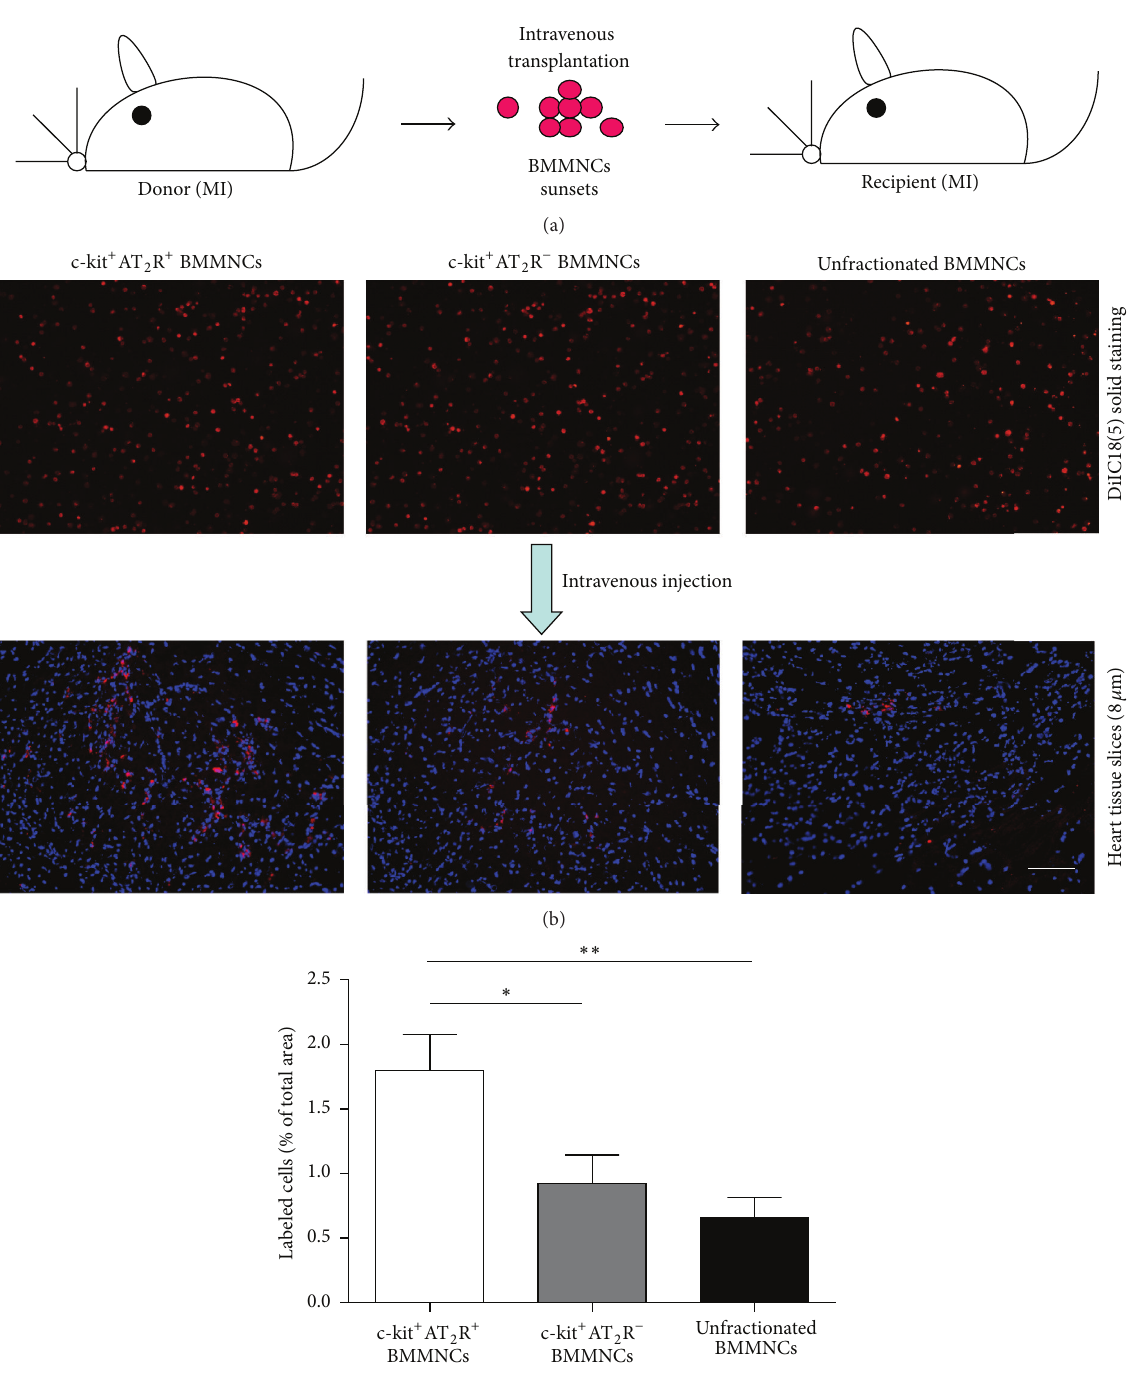
Figure 5: Homing capacity of BMMNC subsets in vivo . (a) Transplantation scheme showing BMMNC subsets derived from MI mice transplanted into MI recipients. (b) DiIC18(5) solid staining (red, upper panel; scale bar = 50 𝜇 m). Labeled BMMNC subsets were evaluated 7 days after transplantation (lower panel; scale bar = 50 𝜇 m). (c) Quantification of homing cells (labeled cells/total area %). ∗ 𝑝 < 0.05 and ∗∗ 𝑝 < 0.01